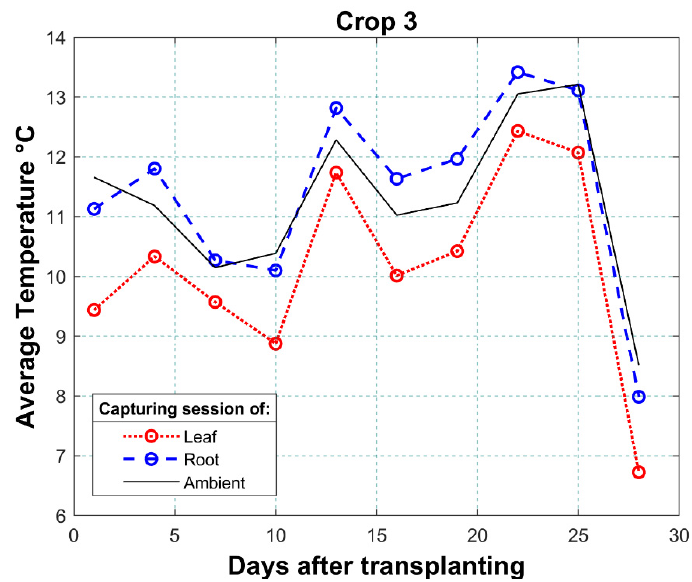
Figure 9. Average root, leaf and ambient temperature during the growing period. Table 3. Leaf and root average temperature for the three crops. “a” means that there is no signifi- cant difference between leaf and root temperatures for crops 1 and 2.